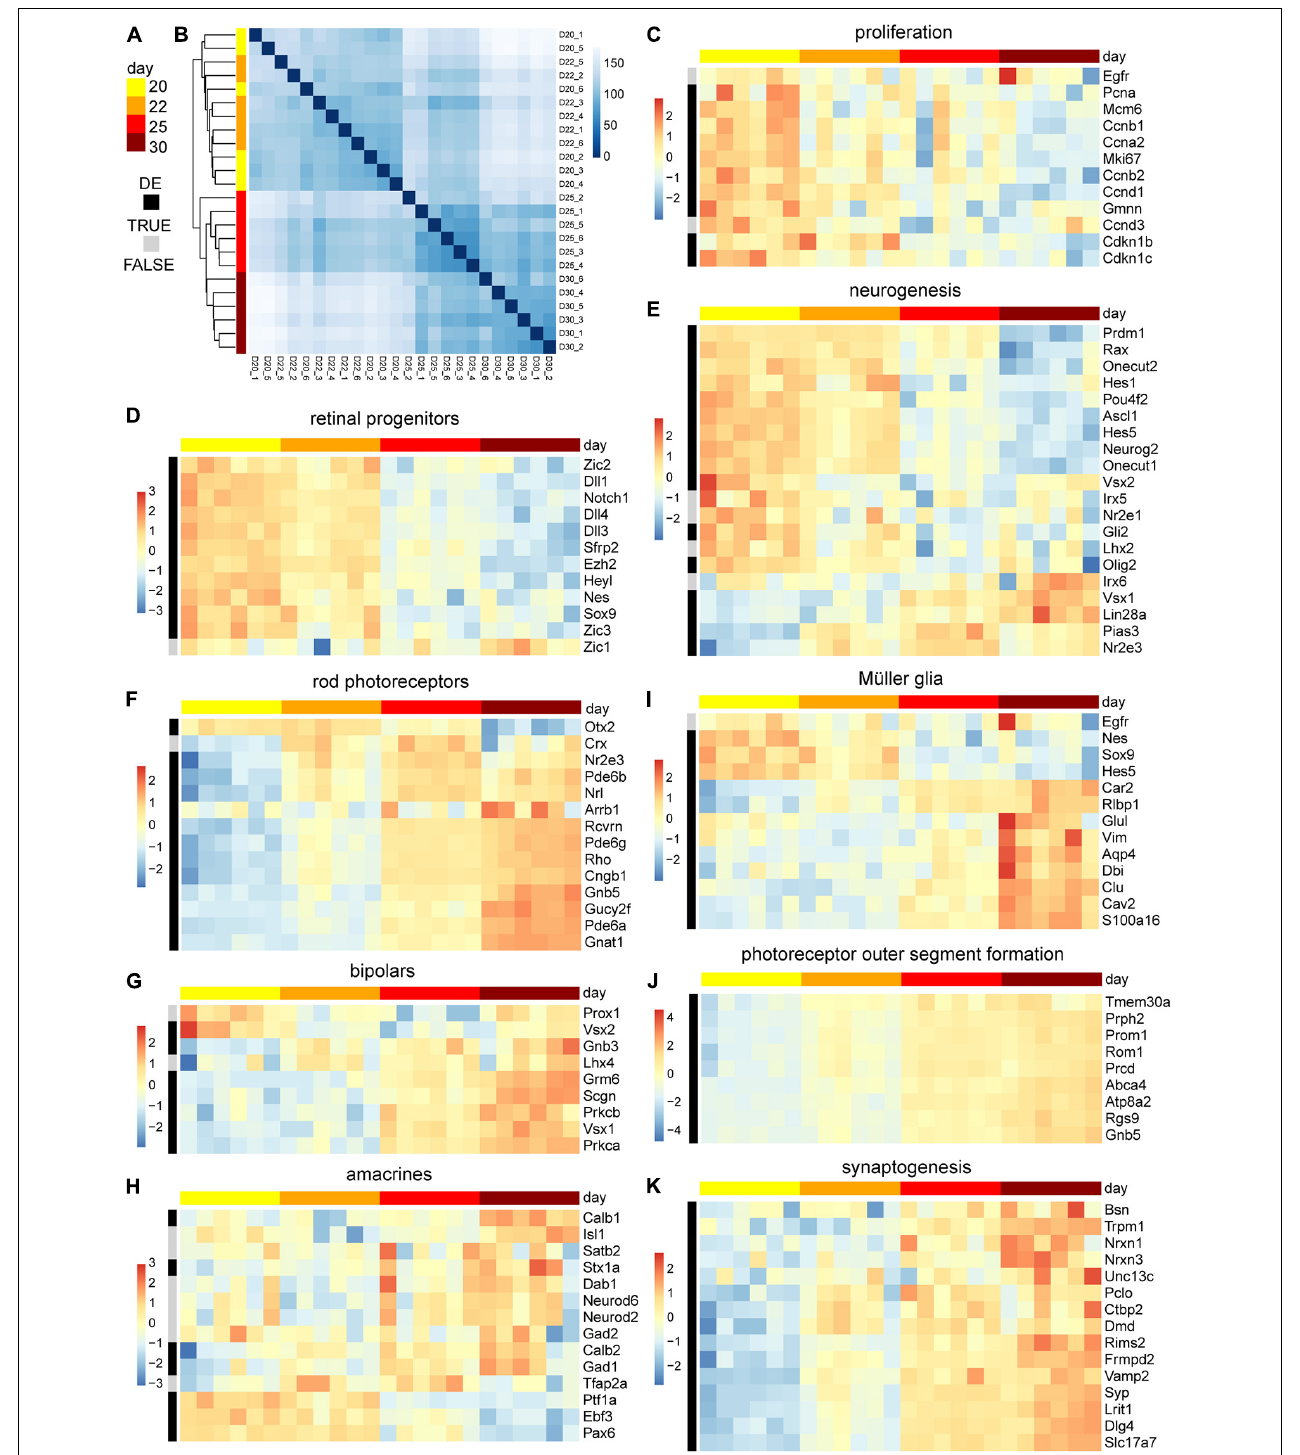
FIGURE 6 | Transcriptome analysis of retinal maturation of the MRO system. (A) Color code of column and row annotation of the heatmaps indicate MRO sample age and differential gene expression (DE, FDR ≤ 0.01), respectively. D, day. (B) Sample-to-sample distance matrix (with clustering) for overall gene expression based on normalized counts shows low variation between individual samples per timepoint and a clear separation of the early (D20–22) and the later (D25–30) time points. (C–K) Heatmaps of selected genes of interest to study temporal changes in the gene expression associated with retinal progenitors, and neurogenesis of the major retinal cell types and their maturation. The heatmaps scales depict z -scores of log transformed counts. 6 MRO samples per timepoint were analyzed.